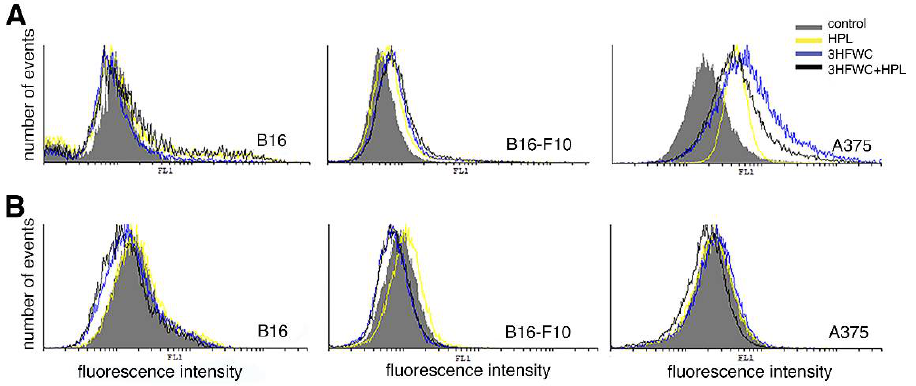
Figure 6. Production of nitric oxide (NO) and reactive oxygen and nitrogen species (ROS/RNS) in melanoma cells after the treatments with 3HFWC and/or HPL. ( A ) DAF-FM diacetate staining; ( B ) dihydrorhodamine 123 (DHR123) staining.